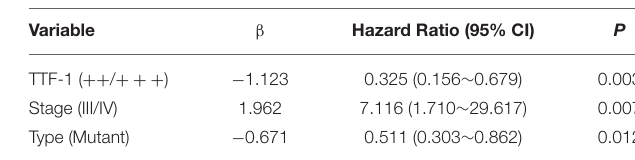
TABLE 5 | Establishment of the Cox proportional risk regression